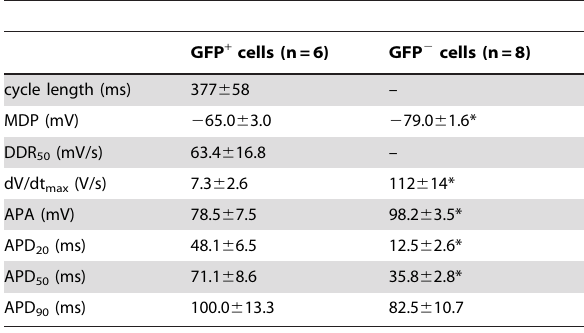
Figure 4. Isl1 cells have pacemaker activity. ( A–C ) Optical mapping on an explanted, contracting adult zebrafish tg(isl1BAC:GalFF; UAS:GFP) heart. Arrow indicates the sinus venosus in all panels. (A) Explanted adult zebrafish heart. (B) GFP-fluorescent cells reporting Isl1 expression are situated at the sinus venosus. (C) The activation pattern measured by di-4-ANEPPS fluorescence shows that the GFP + myocytes are situated in the area of earliest activation. ( D ) Typical action potentials of freshly isolated GFP + and GFP 2 myocytes. The GFP 2 cell was stimulated at 3 Hz. The inset displays a representative example of a GFP + myocyte. doi:10.1371/journal.pone.0047644.g004 Table 1. Action potential characteristics of single GFP + and GFP 2